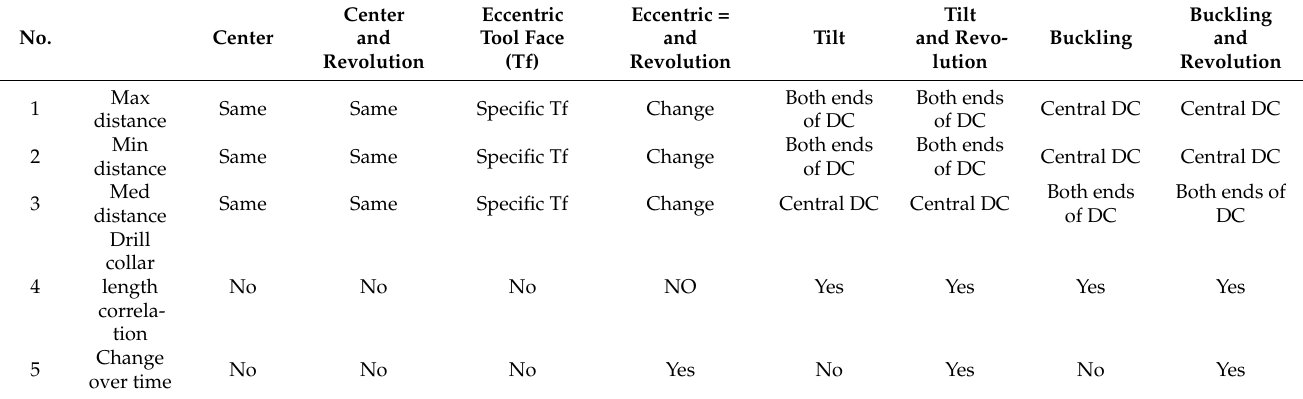
Table 3. Characteristic statistics of drill collars with different postures and additional revolutions in the wellbore.